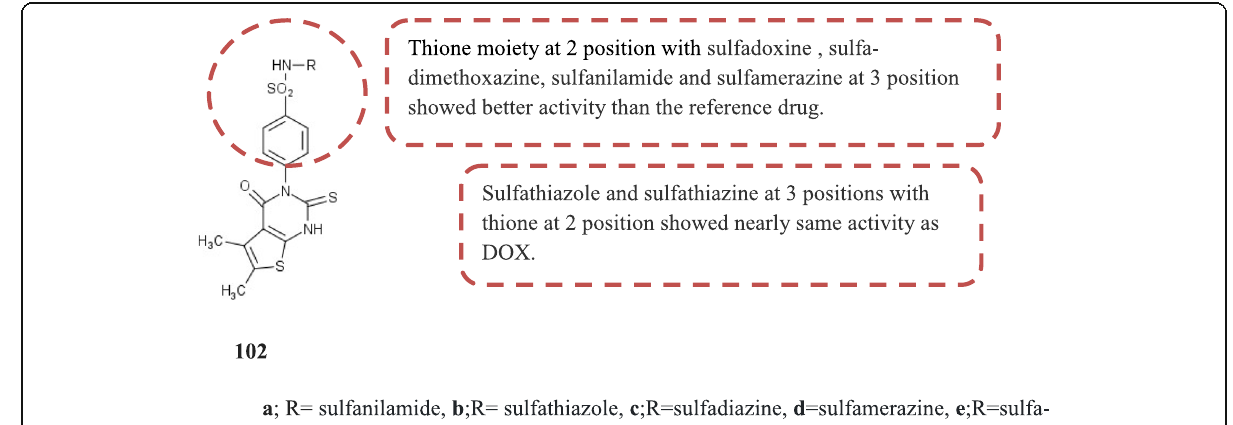
Fig. 35 SAR studies and chemical structures of new tetrahydrobenzo [4,5]thieno [2, 3-d] pyrimidine-4-yl)-pyrolidine-2-carboxylic acid